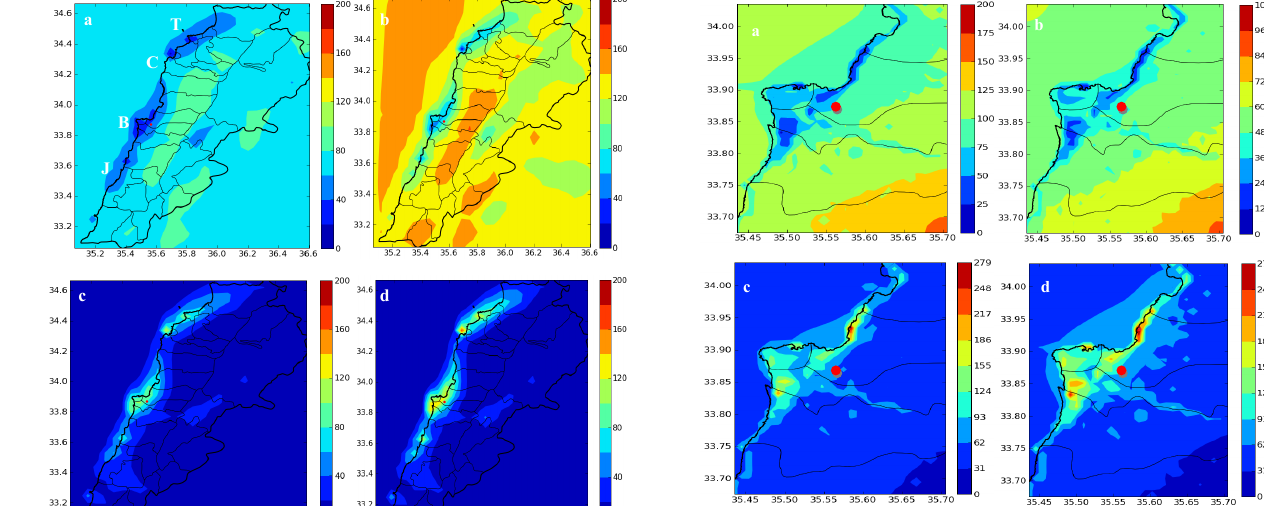
ratio for the inner domain D1. 3 x